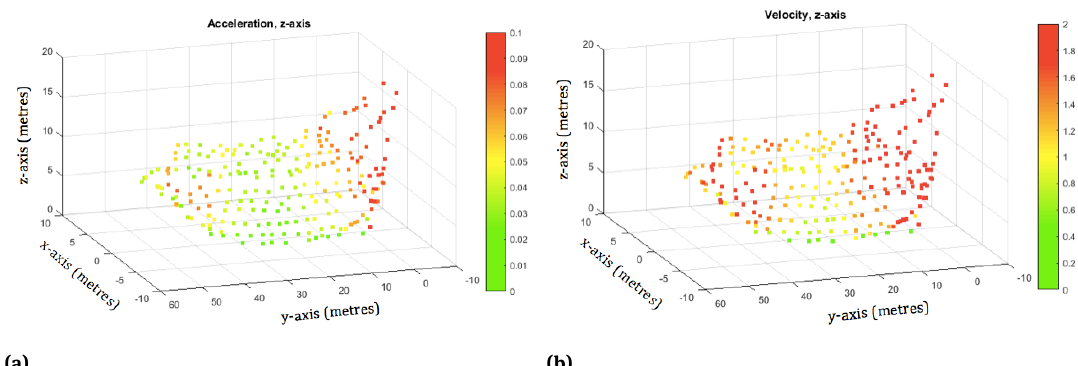
Figure 5: a) Accelerations [mm/year 2 ] and b) velocities along z -axis